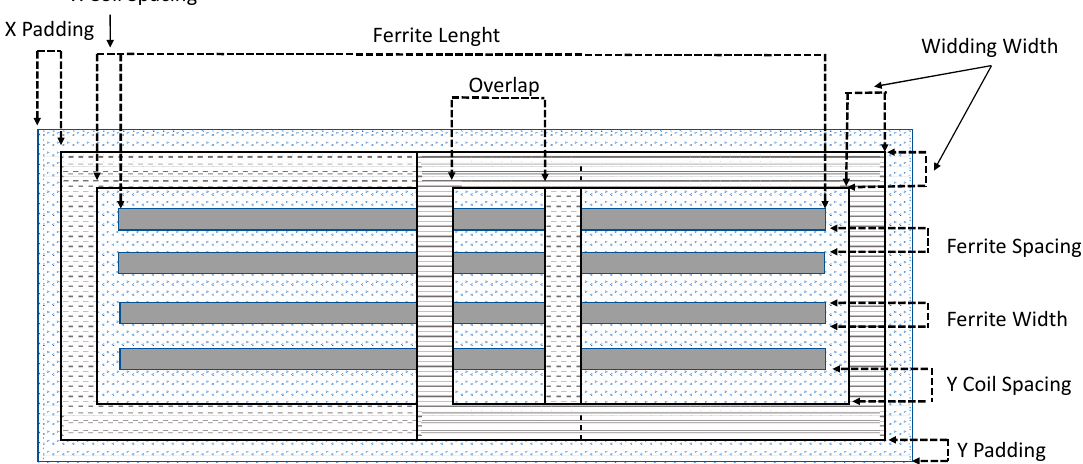
Figure 7. Design of the bipolar pad (BPP) pad showing the major dimensions [32].